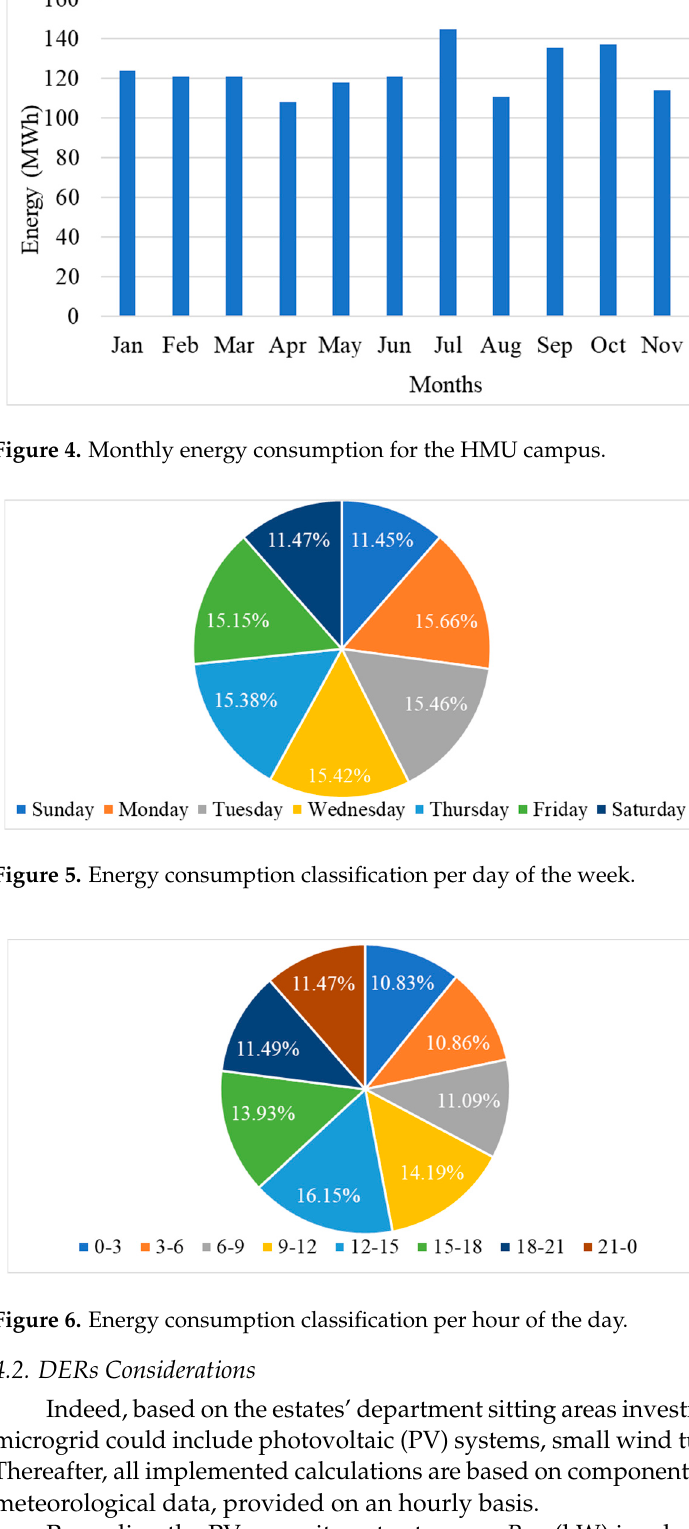
7 of 20 Figure 2. Hourly time series for load demand for the HMU campus. Figure 3. Duration curve of load demand for the HMU campus. As previously mentioned, a factor affecting the campus’s energy consumption is the